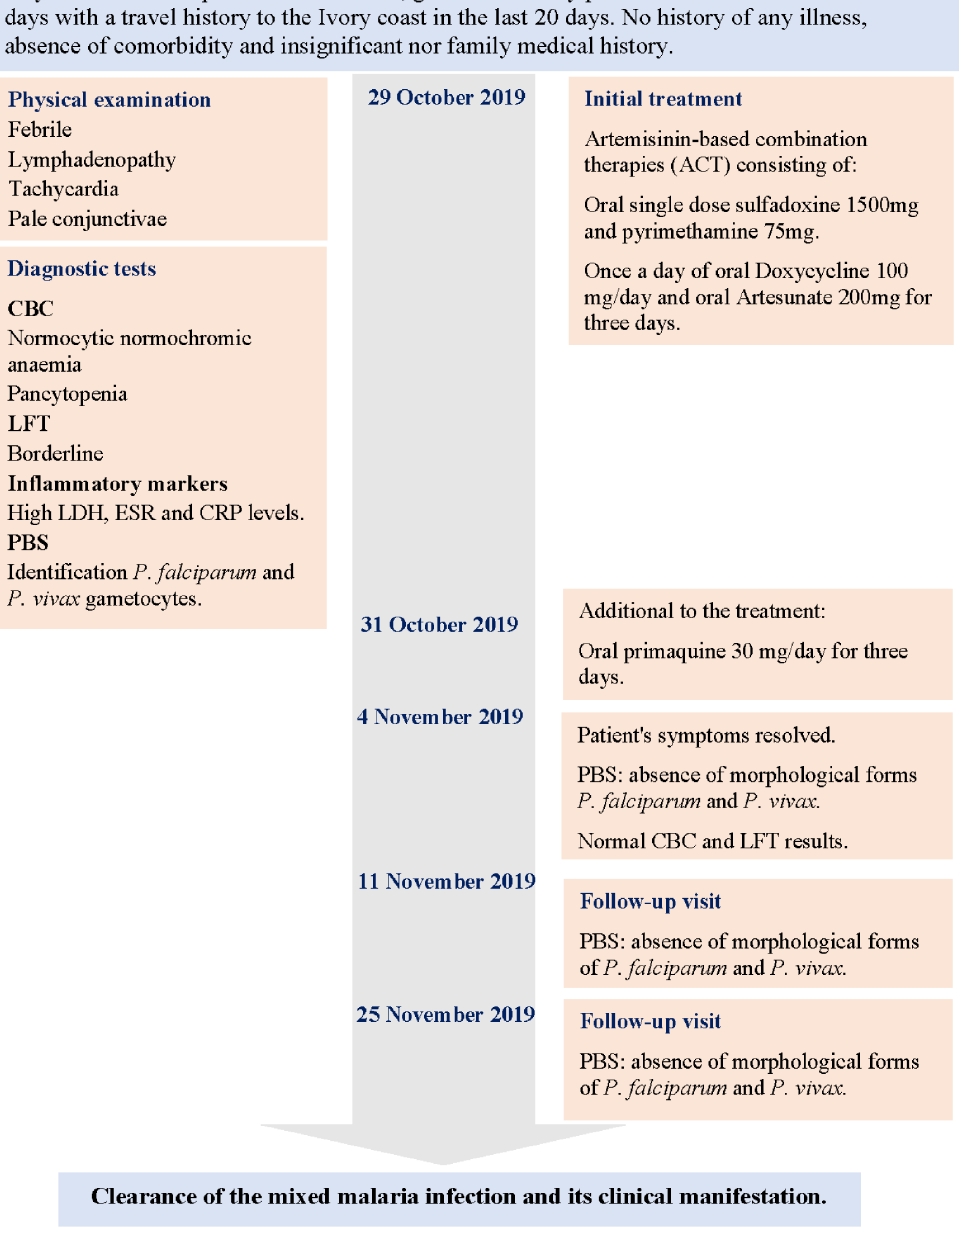
Figure 1. Case management timeline of P. falciparum and P. vivax mixed infection. CBC Complete blood count; LFT Liver function test; LDH Lactate Dehydrogenase; ESR Erythrocyte sedimentation rate; CRP C-reactive protein; PBS Peripheral blood smear.